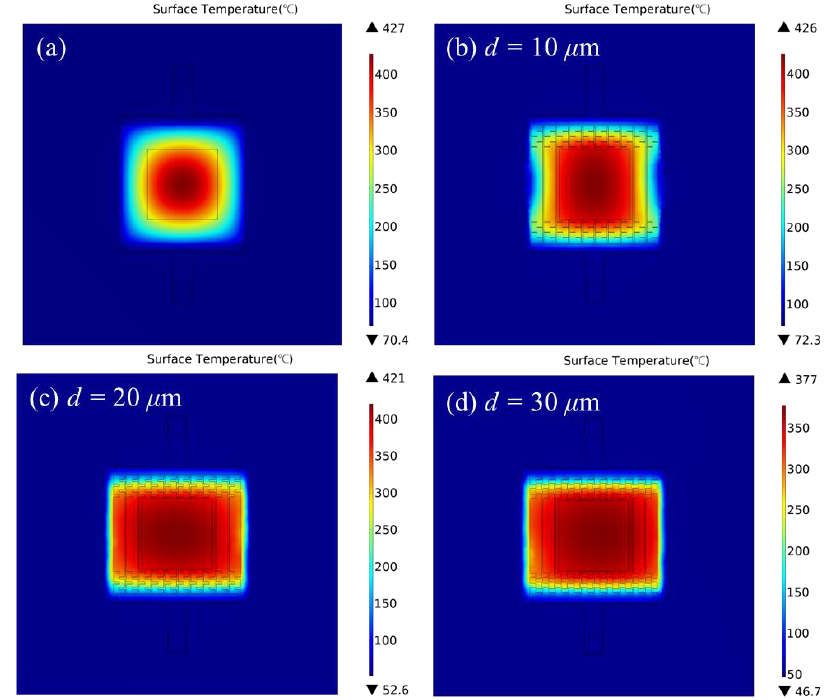
Figure 5. Simulation results of surface temperature and thermal distribution